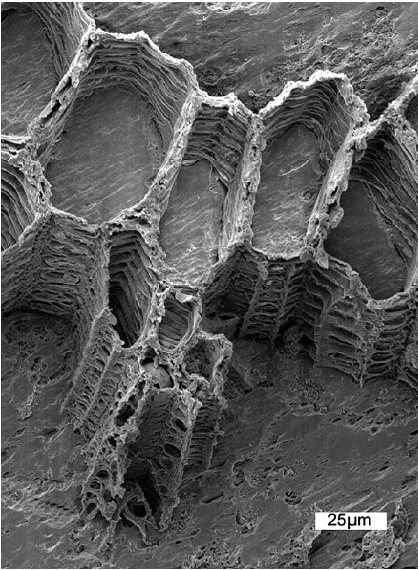
Figure 7. Permineralization: cell walls of Lower Jurassic fern Osmundastrum pulchellum from Korsar ő d, Sweden, revealed by HCl dissolution of calcareous matrix to reveal original cell walls [14]. Photo courtesy of Stephen McLoughlin.